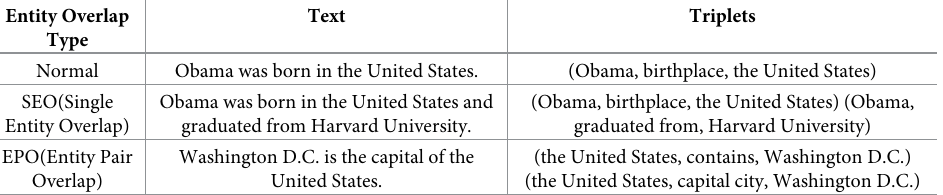
Table 1. Examples of entity